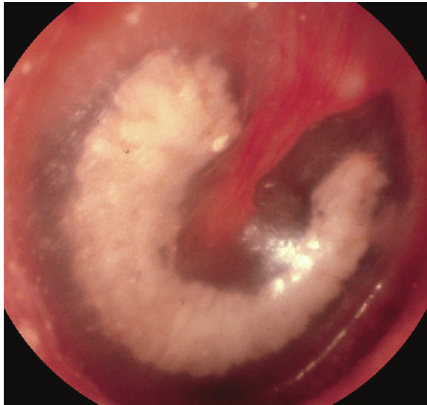
Figure 4: Endoscopic view of typical appearing tympanosclerosis in a right ear. Note the white plaque present within the substance of the eardrum. The middle ear is aerated (image courtesy of Dr. Abraham Jacob,